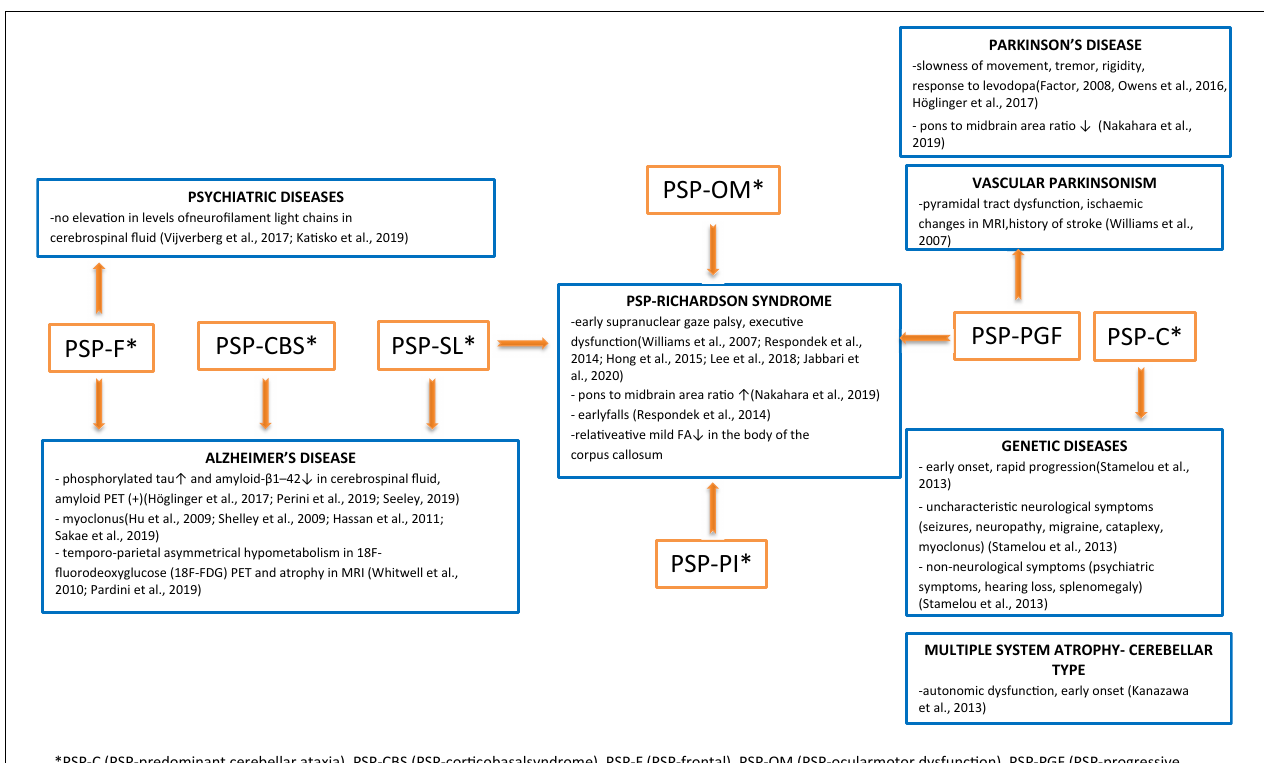
FIGURE 1 | Summary of the differential diagnosis of rare Progressive supranuclear palsy (PSP) subtypes with the indication of uncharacteristic features that lead to deeper diagnostics in the direction of specific disease entities.